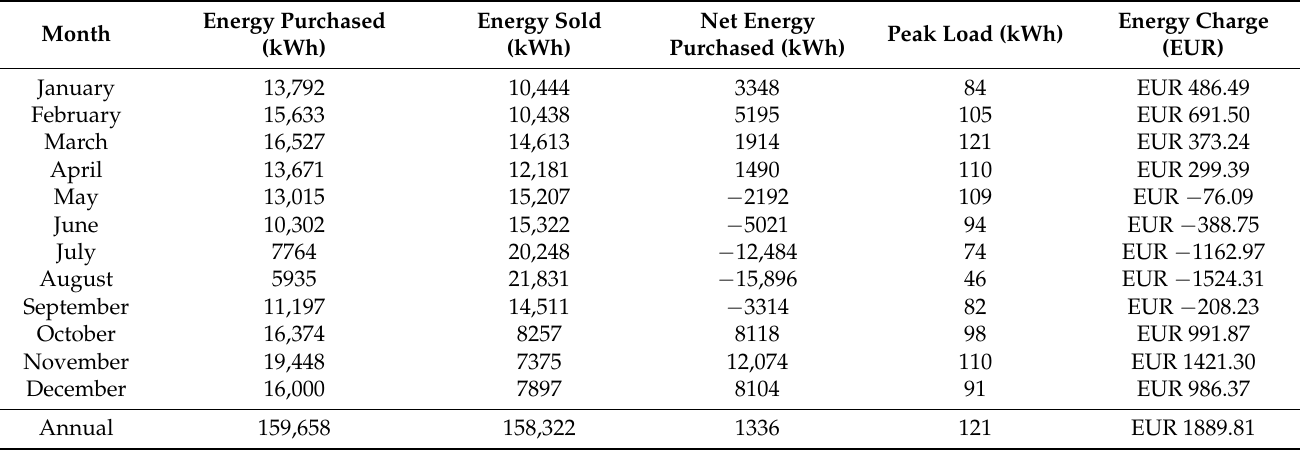
Table 7. Calculation of electrical energy consumption and cost by month of year.